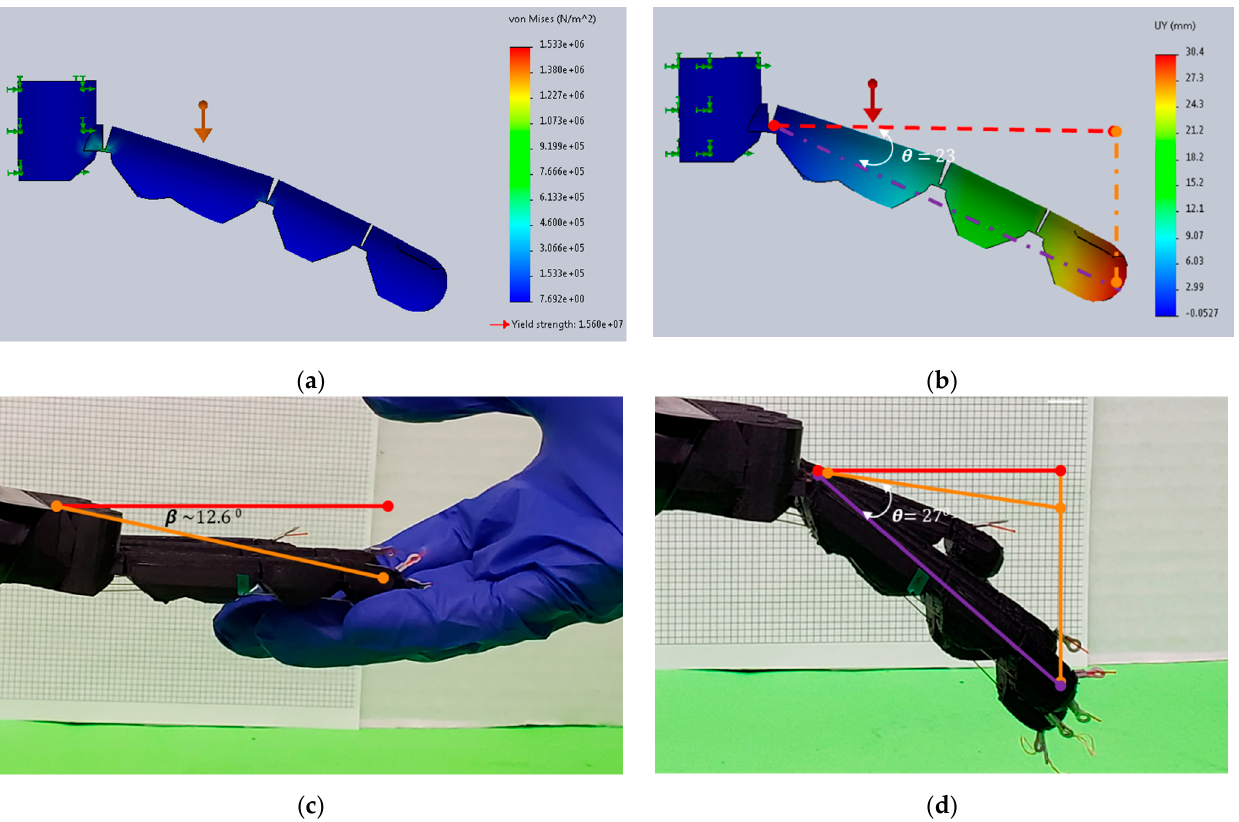
Figure 13. Simulation and experiment of the index finger bending due to gravity, without tendons and actuators, and upside down configuration: ( a ) stress due to gravity load; ( b ) displacement due to gravity; ( c ) supporting the hand with gravity towards downward and ( d ) bending of the finger due to gravity.